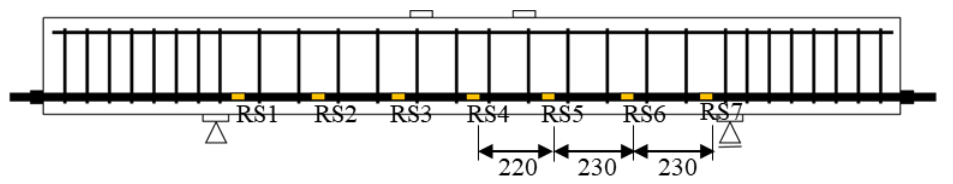
Figure 2. Measurement positions for main rebar strain.